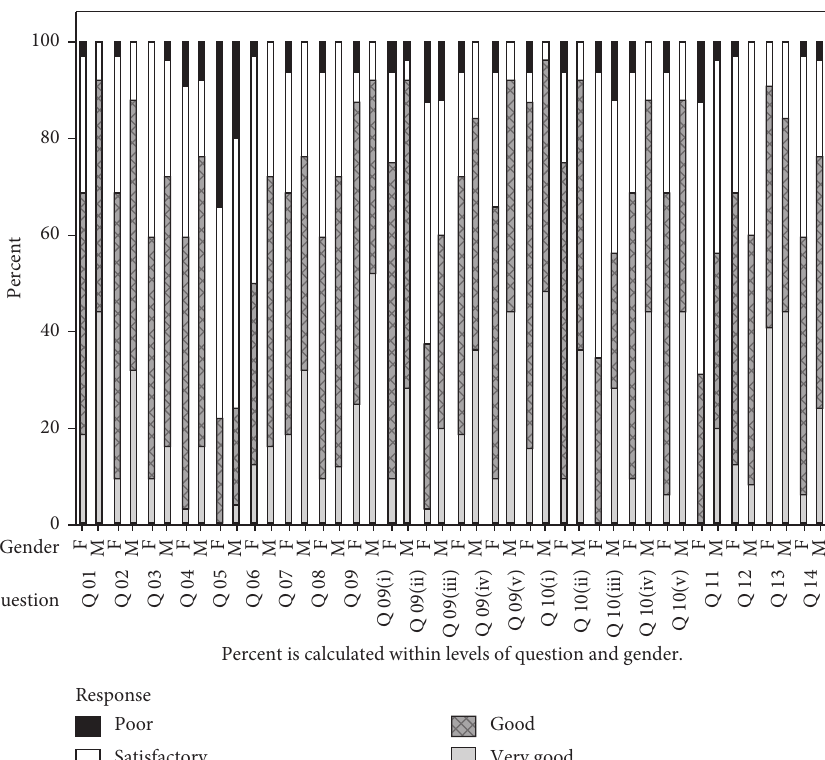
Figure 1: Level of confidence among dental students of the two genders to carry out the complete denture procedure. Table 2: p values showing the level of students’ confidence on management of patients with complete dentures at different steps. Different steps in complete denture